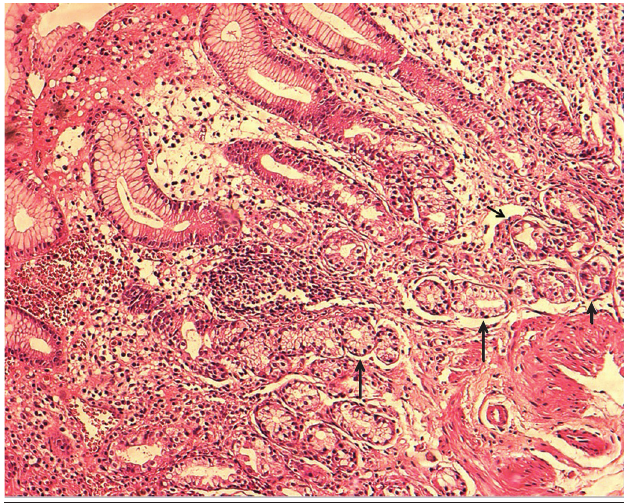
FigurE 1 − Severe glandular atrophy of the gastric corpus. Presence of few remaining oxyntic glands presenting regressive changes (short arrows), and numerous mucous secreting glands, named PSA (long arrows). HE, original magnification 100× PSA: pseudoantral metaplasia; HE: hematoxylin and eosin.